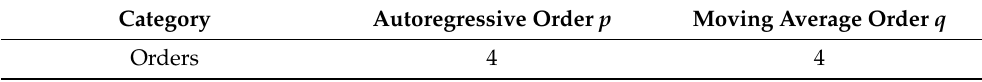
Table 5. Autoregressive order and moving average order of the ARIMA model.